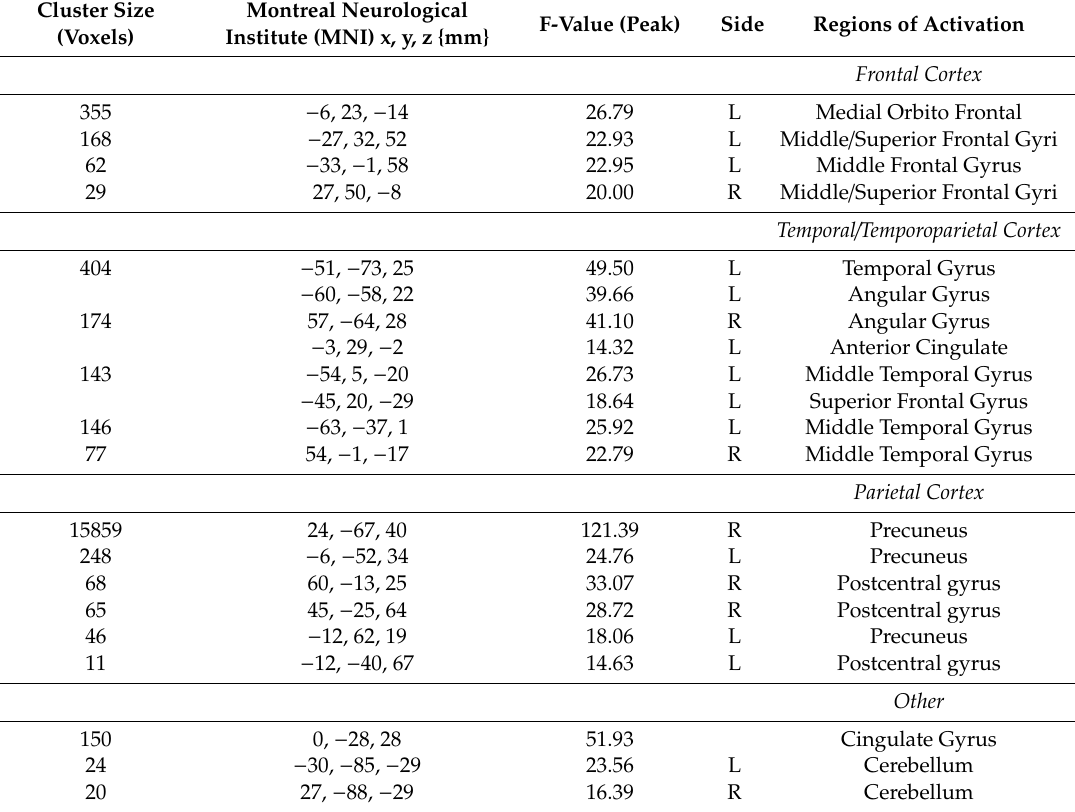
Table 1. ANOVA for the conjunction analysis: all conditional stimuli (CS) (novel and familiar) vs. baseline 1 .